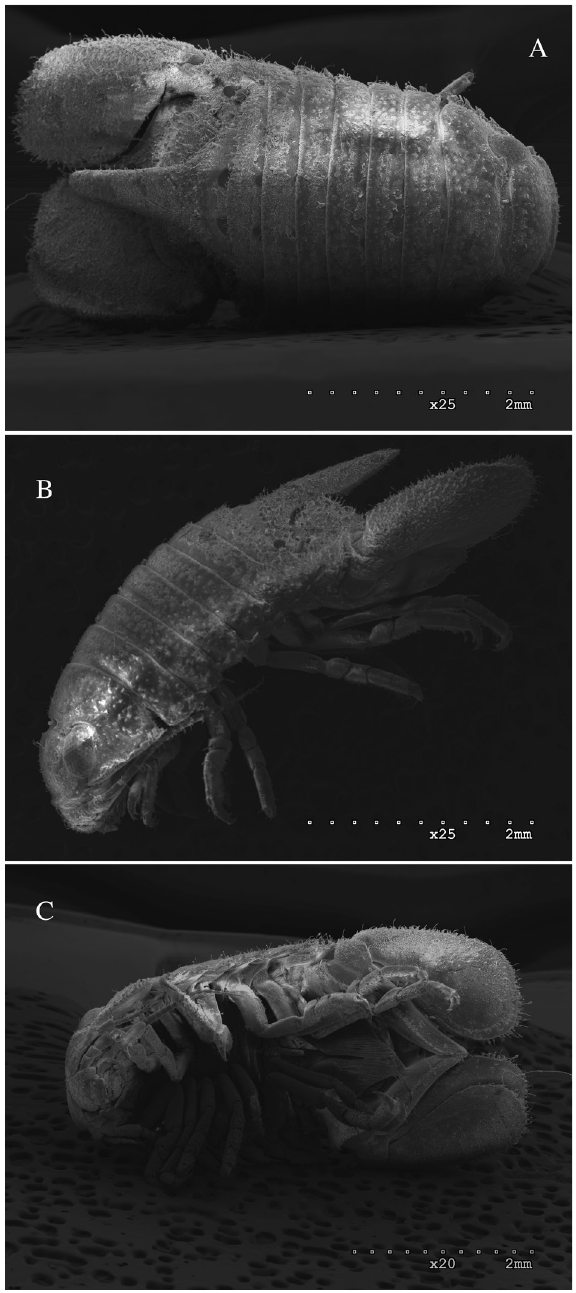
Figure 8. Dynoides dentisinus . ♂ , A dorsal B lateral C ventral. California, Alameda County, San Fran- cisco Bay, off Doolittle Road near Oakland Airport, 37.73°N 122.21°W, from low intertidal under rocks, associated with sponge, salinity 30 ppt, fixed and preserved in 95% ethanol. 5 Jun 2002. Coll. R. Wetzer, T. Haney, and S. Boyce. RW02.027. MBPC